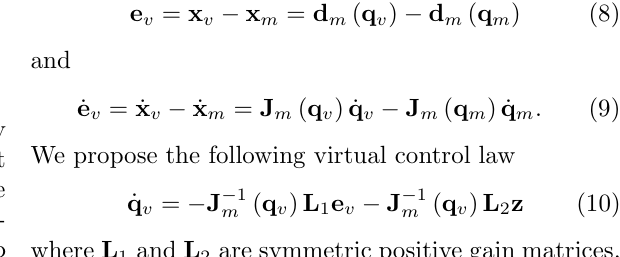
Figure 1: Leader, follower and virtual manipulator robot manipulator where only the length and type of the joints are known, and where only the joint posi- tion and orientation vector q m is measured. However, the virtual manipulator approach is easily adopted to the design in Kyrkjebø and Pettersen (2006) where the restriction of knowing the velocity of the follower ma- nipulator is